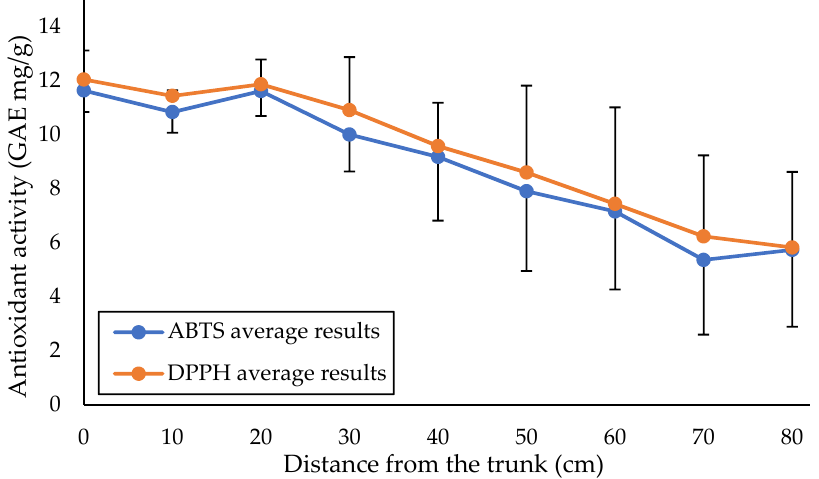
Figure 2. Spectrophotometric determination of antioxidants (ABTS and DPPH). Both measurements decrease significantly with the distance (Pearson correlation R < − 0.95, p < 0.001).